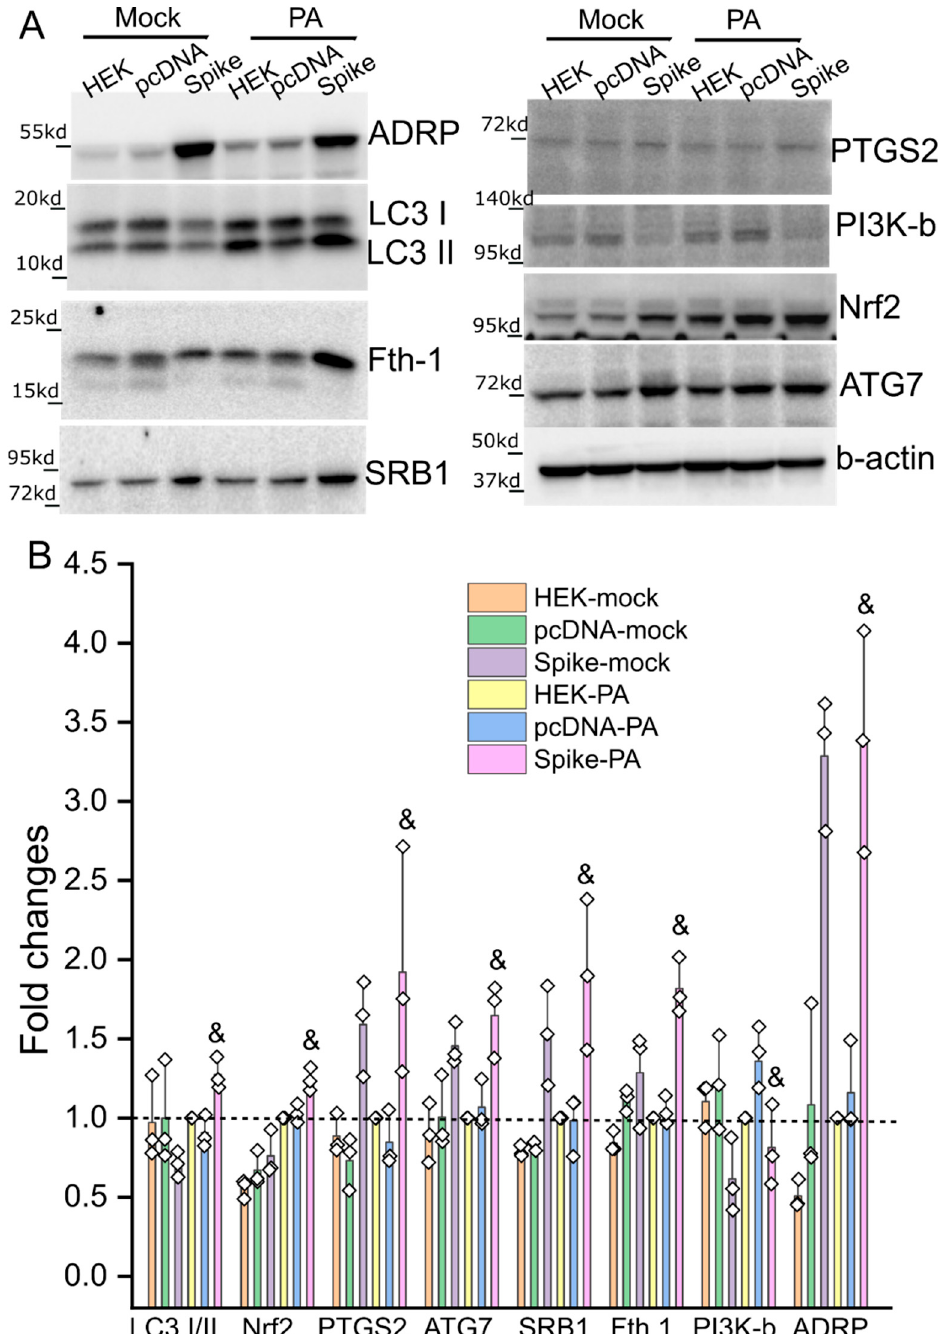
Figure 4. Immunoblot showing the relative changes in levels of some representative biomarkers of impaired lipid metabolism, autophagy, and ferroptosis in response to PA overload. The mock, pcDNA, and Spike cells were treated by 750 µM PA for 24 h in DMEM containing 5% FBS. ( A ) Representative immunoblot showing the protein levels of ADRP, LCI/II, Fth1, Nrf2, PTGS2, PI3K-b, SRB1, and beta-actin in the mock, pcDNA, and Spike cells with or without PA treatment. ( B ) The relative quantification of each biomarker in cells. The protein level for each biomarker was first normalized to the corresponding beta-actin level. The relative ratio of each biomarker within group was then obtained using its’ level in the mock group with PA treatment as 1 (indicated by the dashed line). & indicates p < 0.05 in the Spike cells as compared with the pcDNA control cells with the PA treatment. n = 3 independent experiments.